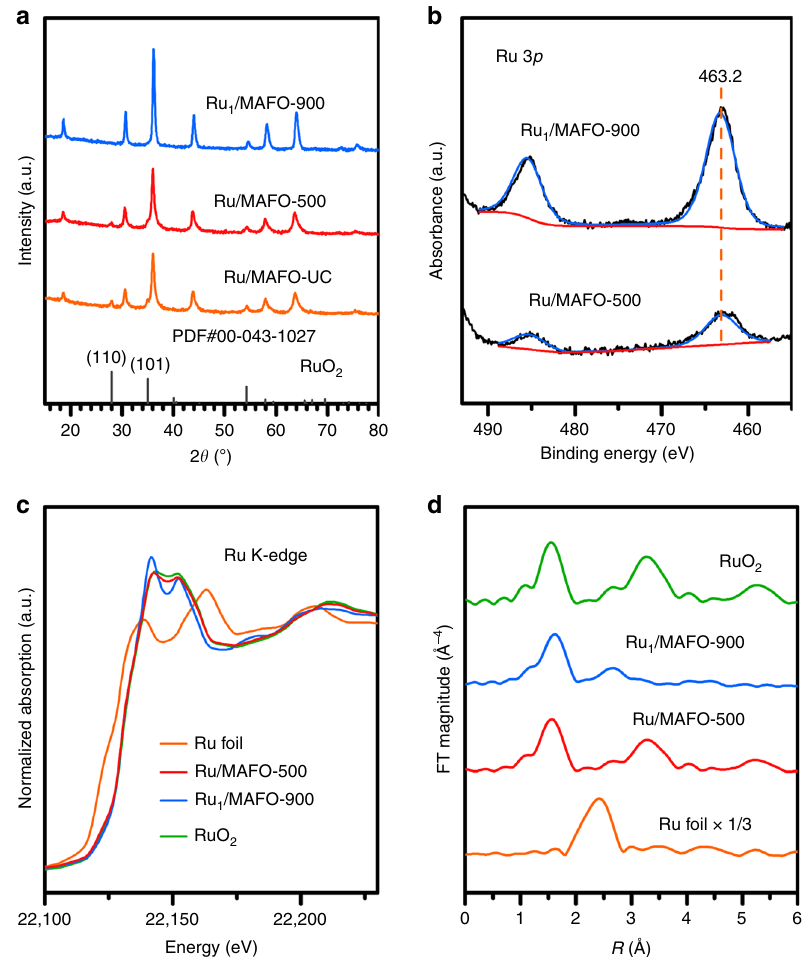
Fig. 2 Structural characterizations of Ru/MAFO samples. a XRD patterns of Ru/MAFO samples and reference materials (PDF#00-043-1027 is the JCPDS card number of RuO 2 ). b Ru 3 p XPS of Ru/MAFO samples. c Normalized Ru K -edge XANES of Ru/MAFO samples and references. d Fourier transforms of k 3 -weighted Ru K -edge EXAFS spectra of Ru/MAFO samples and references (without phase correction).